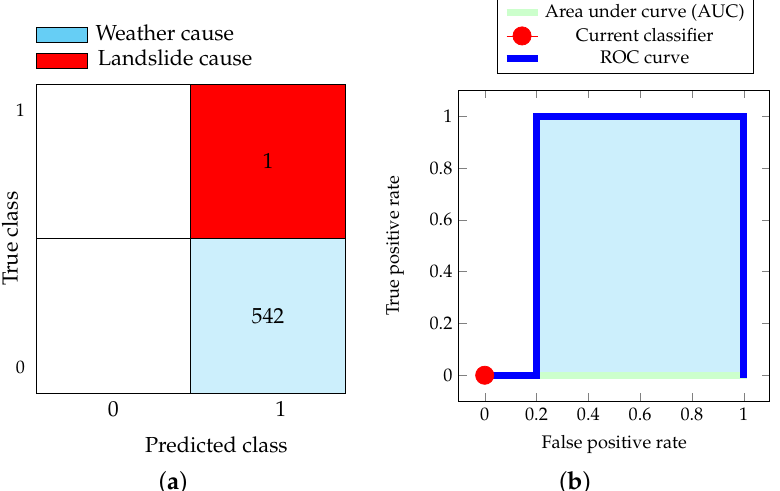
Figure 13. Investigation on the Receiver Operating Characteristic (ROC): ( a ) confusion matrix of the classifier and ( b ) evaluation of the system